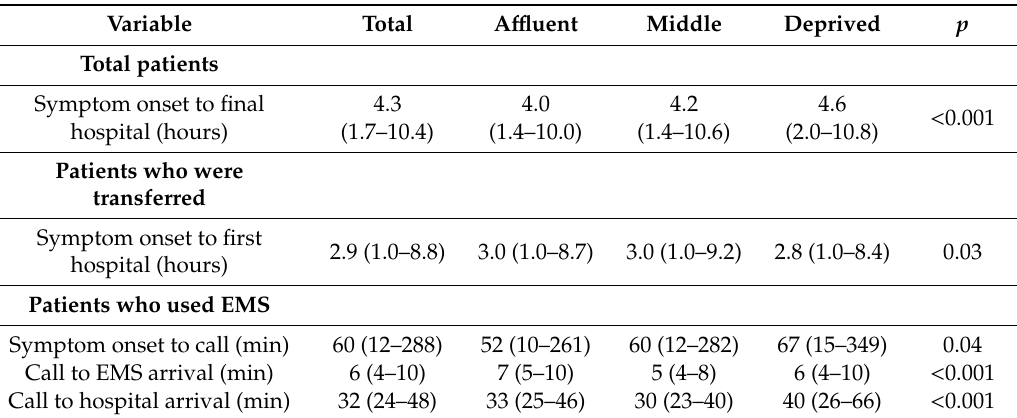
Table 2. Prehospital time intervals by area-level